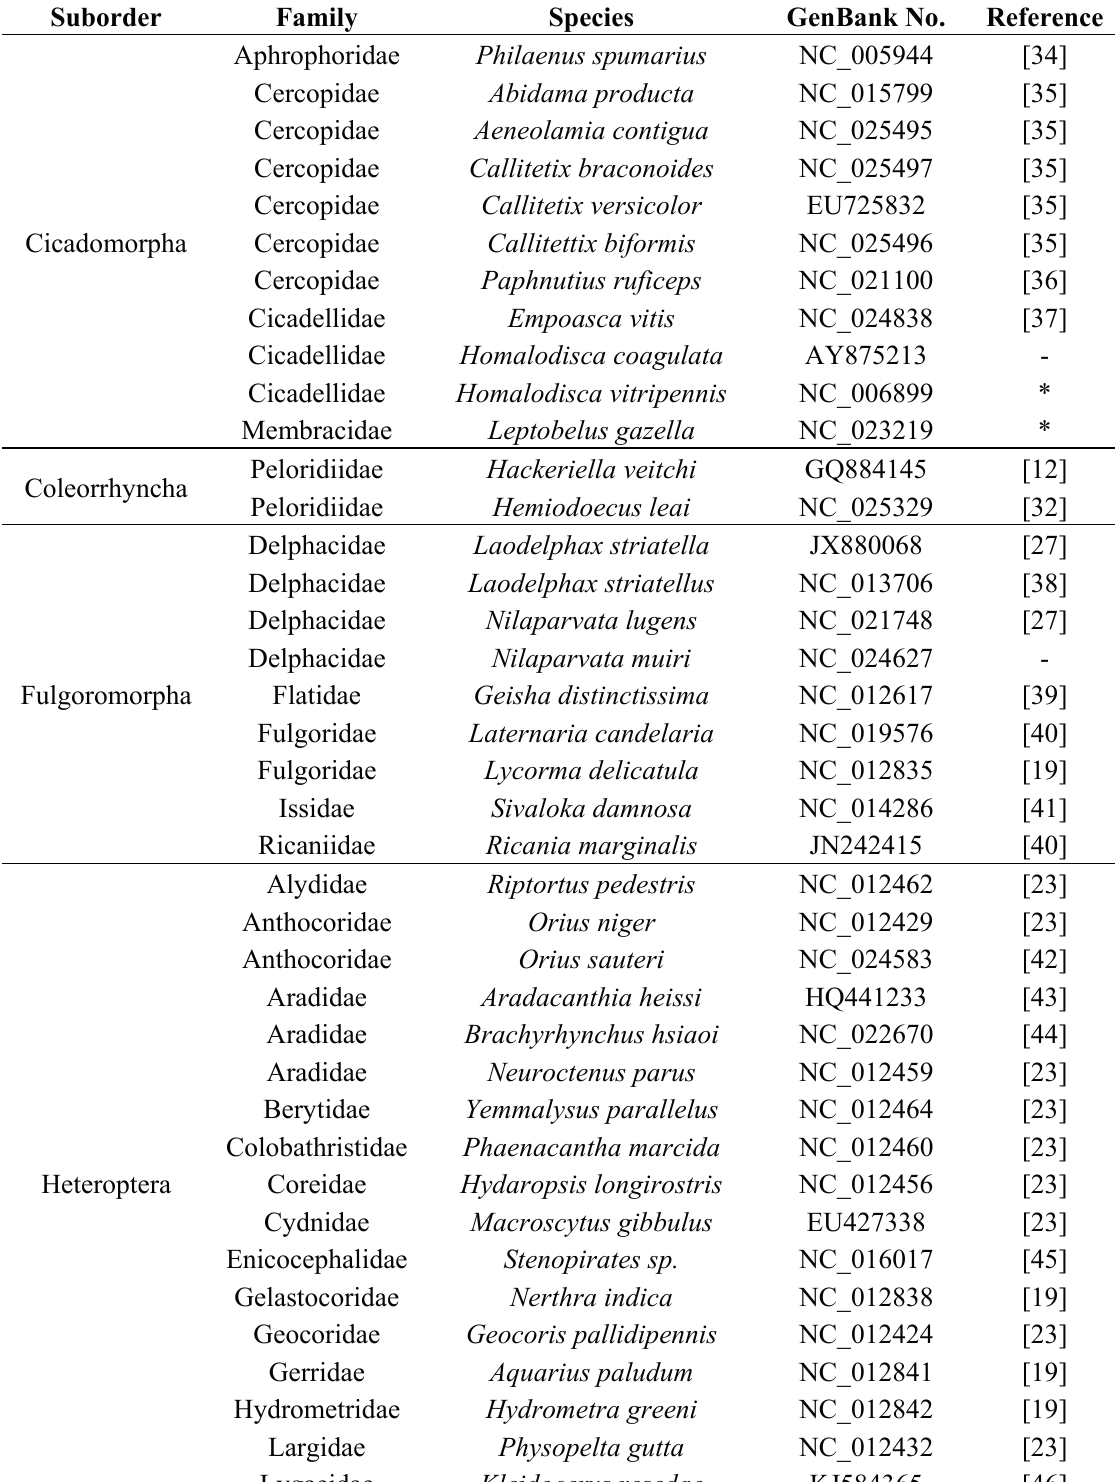
Table 1. All available complete mitogenomes of Hemiptera.